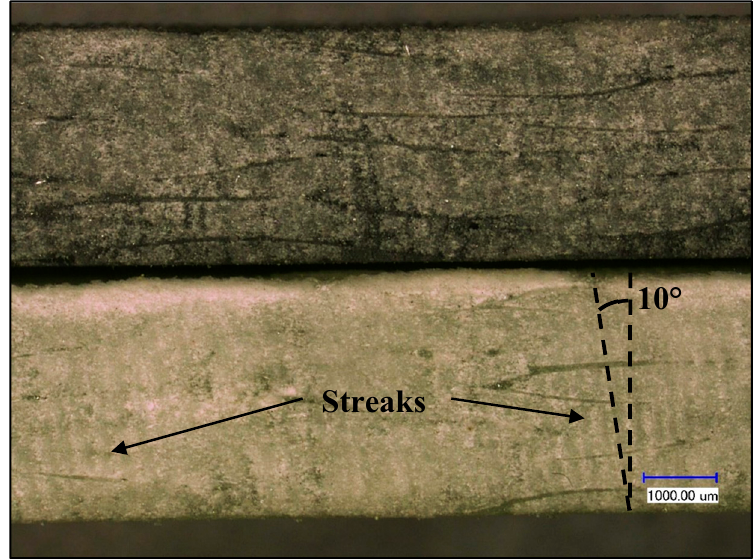
Figure 10. Micrograph of machined surface of GFRP with ( top ) and without ( bottom ) graphene.